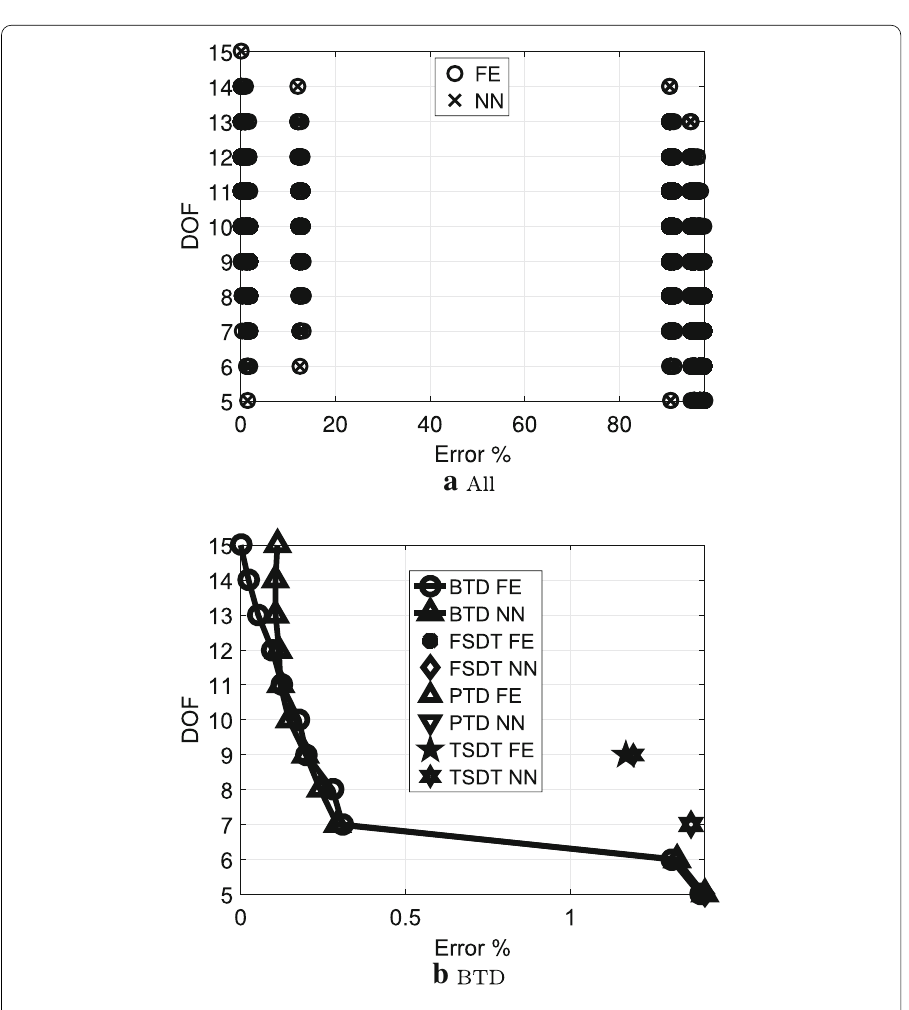
Fig. 14 FE and NN results for 0/90/0/90, a/h = 50, three layers with ten